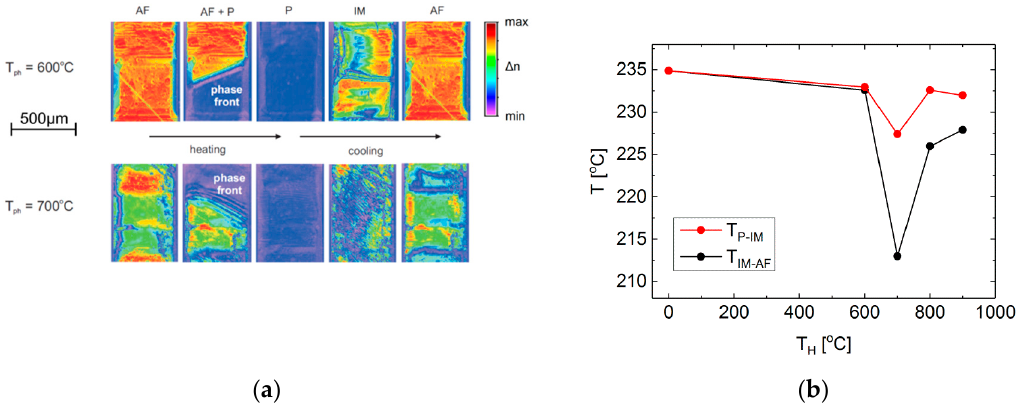
Figure 1. ( a ) Maps of birefringence obtained on heating and cooling. The color change from pink to red (as seen in the phase front of the transition from antiferroelectric (AF) to paraelectric (P) phase) indicates the changes in birefringence from minimum to maximum value. The phase transition from AF to P state could be observed on heating, and from P state to intermediate phase (IM) on cooling. Along with further reduction of temperature, it was possible to observe the transition from IM to AF phase; (b) Phase transition temperatures from P to IM (denoted as T P-IM ) and from IM to AF phase (denoted as T IM-AF ) as a function of annealing temperature T H , obtained on cooling [31].